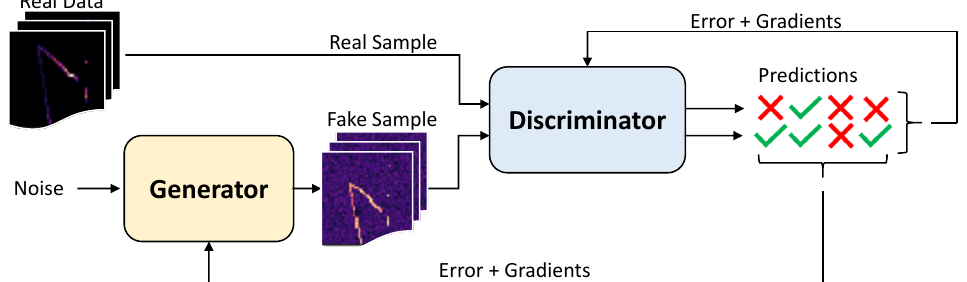
Figure 14. Generative Adversarial Networks (GANs) schematics where the green ticks and red crosses are correct and wrong predictions from the Discriminator respectively.